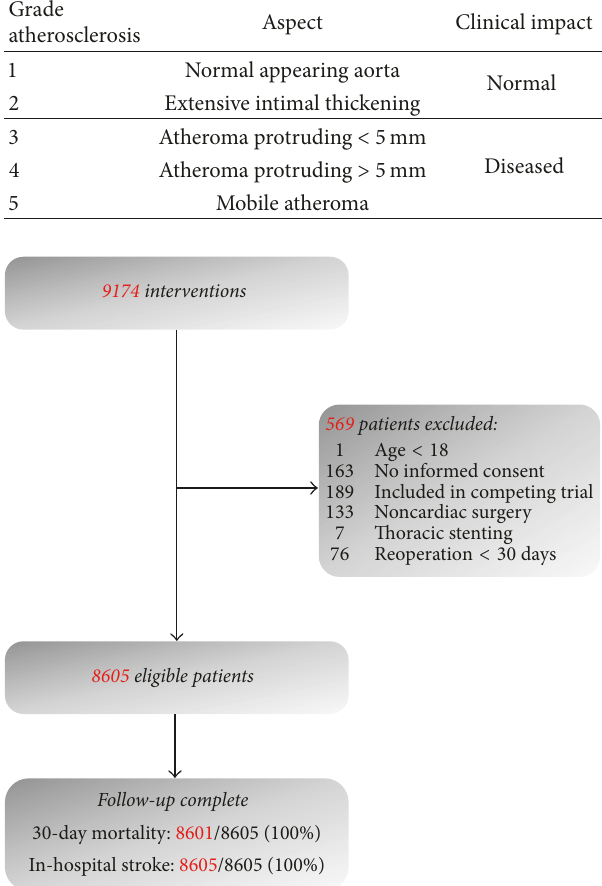
Figure 1: Flowchart of patient